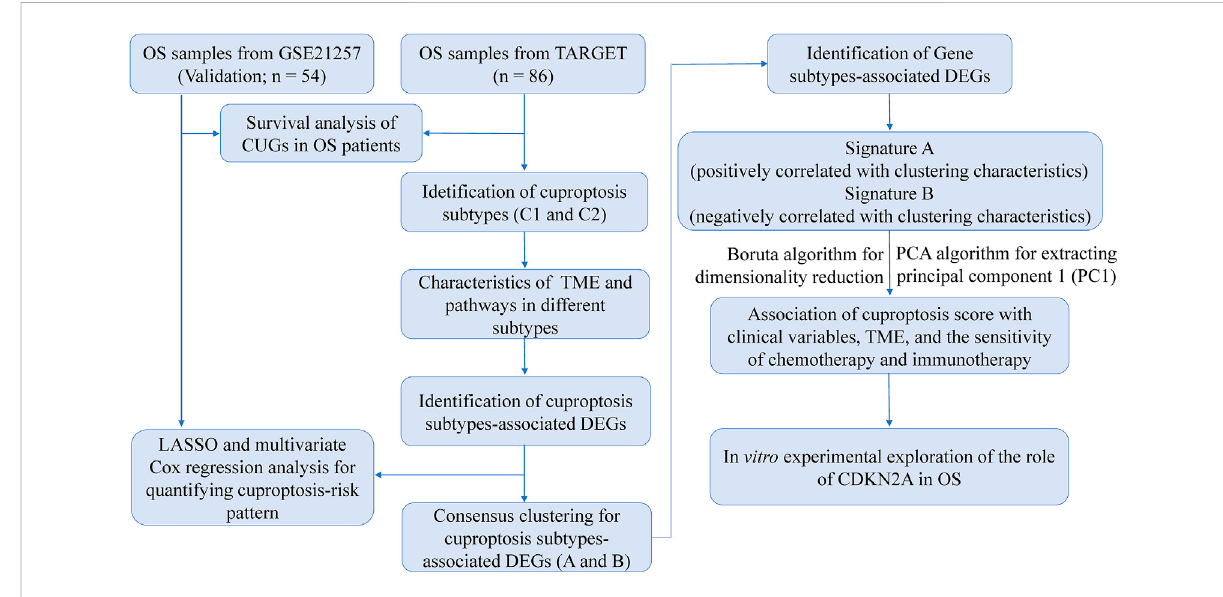
FIGURE 1 A fl ow chart showing the details of the